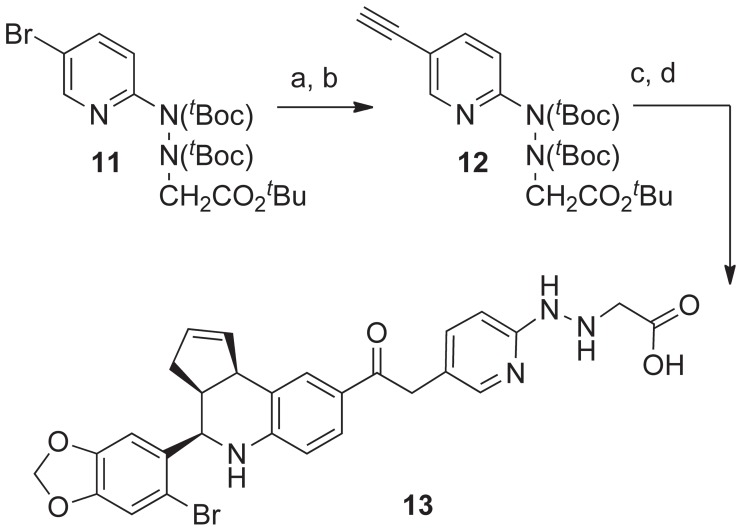
Synthesis of pyridin-2-yl-hydrazinylethanoic acid ligand 13.Reagents and conditions: a) TMS-acetylene, PdCl2(PPh3)2 (10 mol%), CuI (8 mol%), Hunigs base, NMP, 80°C, 2 h, 94%; b) AgOTf (20 mol%), CH2Cl2/MeOH/H2O (7∶4∶1), rt, 20 h, 80%; c) 1 (0.85 eq), PdCl2(PPh3)2 (10 mol%), CuI (10 mol%), Et3N, NMP, rt, 6 h, 79%; d) TFA/DCM (0.8∶1.0), 45 min, 13, 96%.